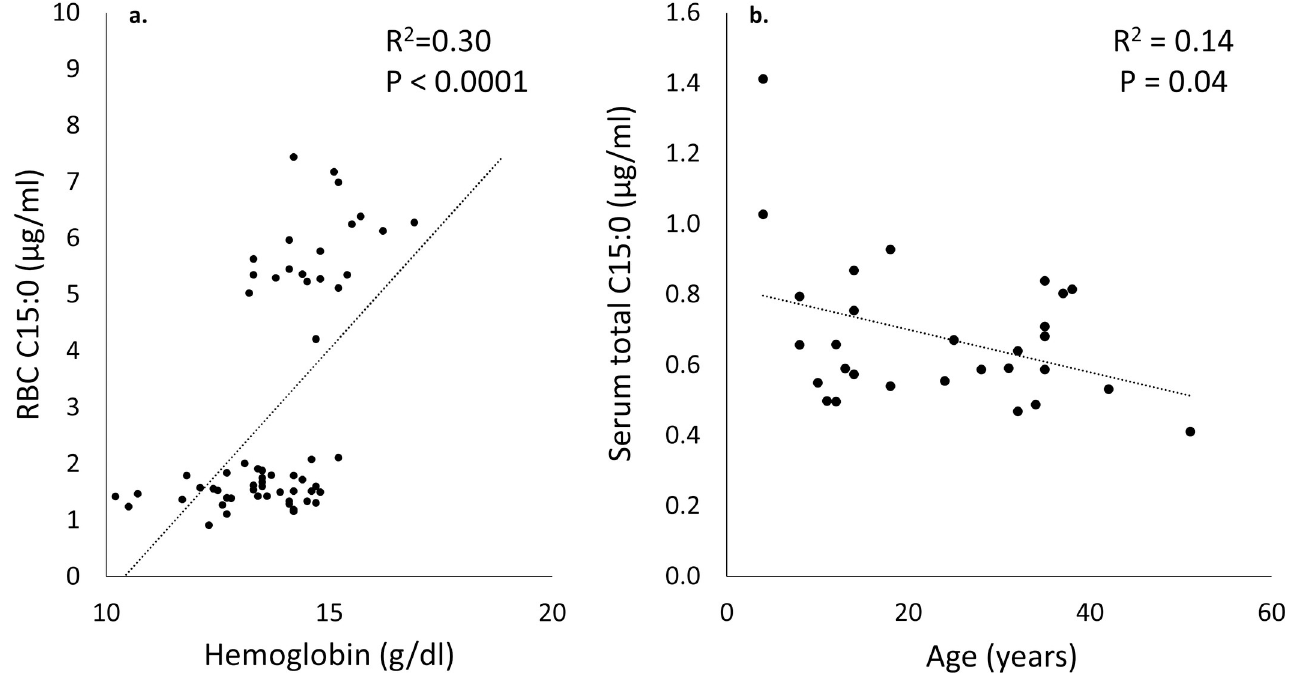
Fig 5. Associations with circulating C15:0, including a) erythrocyte membrane total C15:0 (pentadecanoic acid) as an independent and linear predictor of raised hemoglobin in bottlenose dolphins, and b) inverse associations between serum total C15:0 (pentadecanoic acid) and age in bottlenose dolphins at baseline (Month